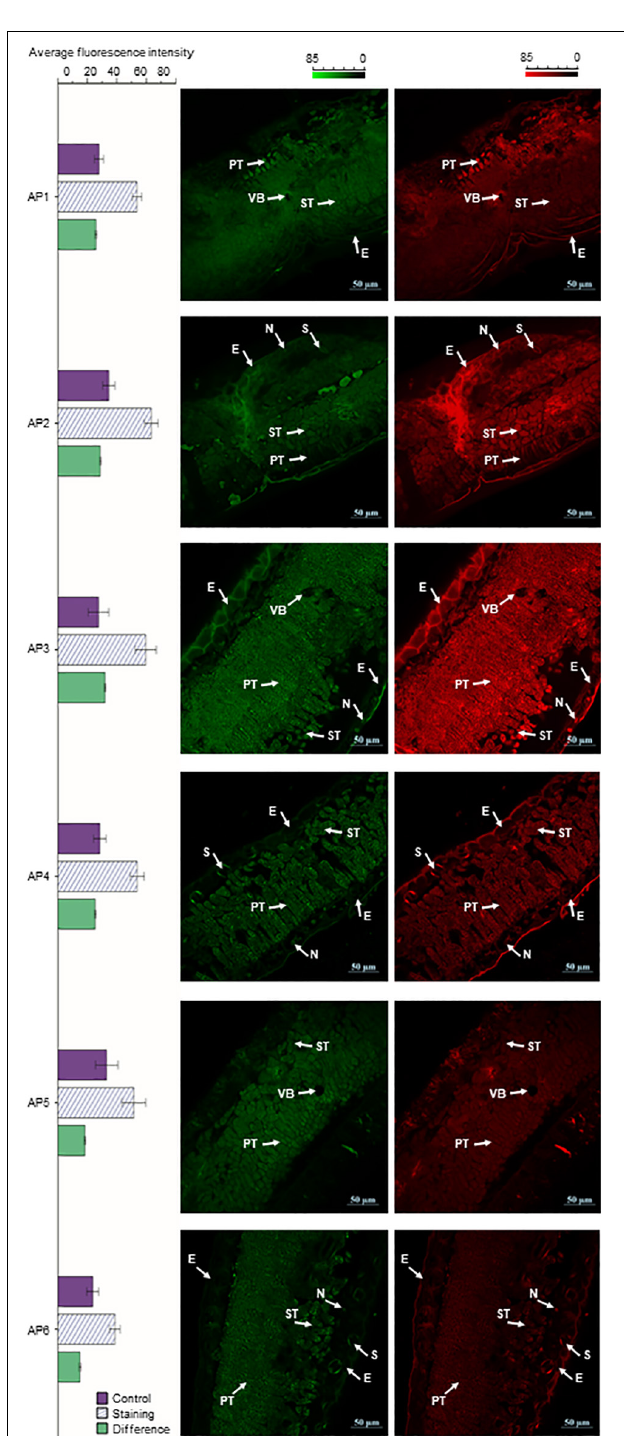
FIGURE 4 | A. pedunculata leaves of different periods were stained with NA solution and observed with CLSM (bar = 50 µ m). The distribution of flavonoids in the cross-section of the A. pedunculata leaves after dyeing is shown. Three independent experiments were performed, and each experiment was tested three times in parallel. Calculate the average fluorescence intensity, and the result p < 0.01 (E, epidermis; N, nucleolus; VB, vascular bundle; PT, Palisade tissue; ST, Spongy tissue; S,